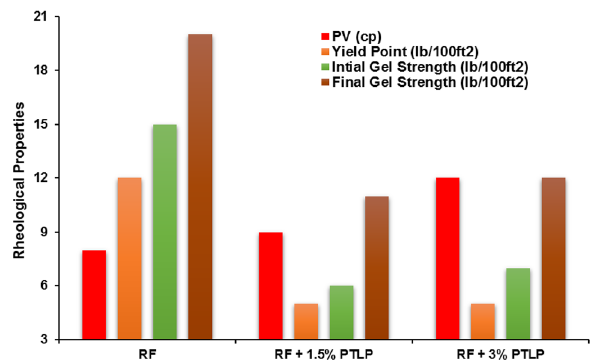
Fig. 5 The influence of PTLP on pH (fresh